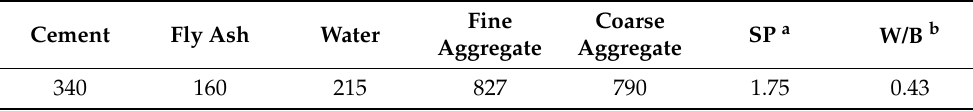
Table 3. Mix proportions of SCC (kg/m 3 ).